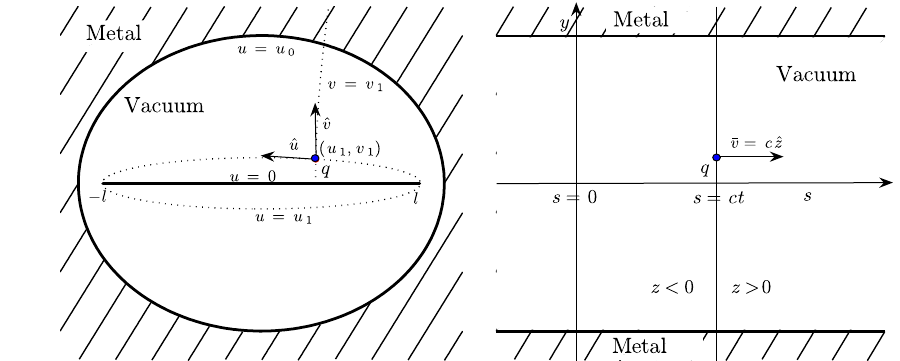
FIG. 1. (Color) The s - y plane view and cross-section plane